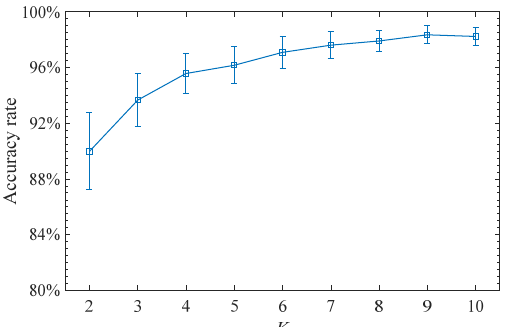
Figure 4. Average AR of every two species with respect to K value based on SVMKM. Error bar is standard deviation of the result of the 55 pairs rapeseed species.